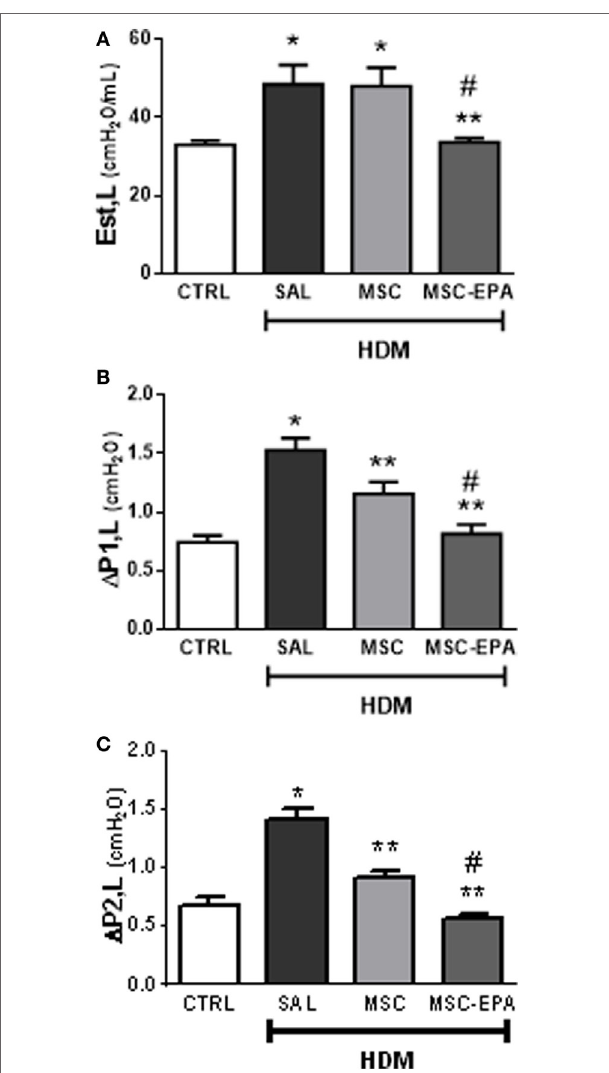
FigUre 6 | EPA-stimulated MSCs led to greater improvement in lung mechanics than unstimulated MSCs. (a) Static lung elastance (Est,L), (B) resistive ( Δ P1,L) pressure, and (c) viscoelastic ( Δ P2,L) pressure. CTRL, saline-challenged mice; HMD, HMD-challenged mice; SAL, HDM mice treated with saline; MSC, HDM mice treated with unstimulated MSCs; MSC-EPA, HDM mice treated with EPA-stimulated MSCs. One-way ANOVA followed by Tukey’s test was used for statistical comparison. Data are presented as mean + SD. n = 8 animals/group. *Significantly different from CTRL ( p < 0.05). **Significantly different from HDM-SAL ( p < 0.05). # Significantly different from HDM-MSC ( p < 0.05). Abbreviations: EPA, eicosapentaenoic acid; MSCs, mesenchymal stromal cells; HDM, house dust